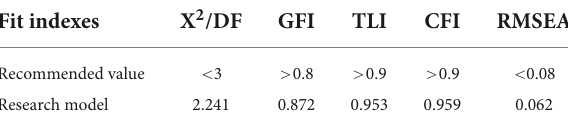
TABLE 5 Goodness-of-fit results of the revised research